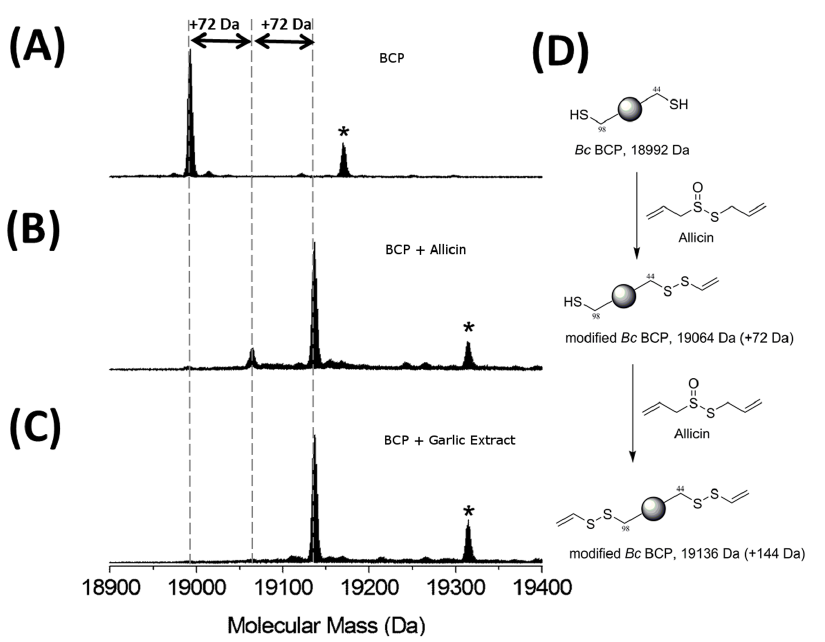
Figure 4. MS analysis of recombinantly produced Burkholderia cepacia BCP Prx incubated with AAS and AGE. (A) Purified Bc BCP Prx has a mass of 18992 Da, consistent with its predicted mass based on the amino acid sequence (B) Bc BCP after incubation with 1 mM AAS for 1 h results in the formation of two covalently modified species of mass increases + 72 Da and + 144 Da. (C) Bc BCP Prx after incubation with AGE for 1 h results in the formation of a covalently modified species of mass increase + 144 Da corresponding to the addition of two allicin adducts. * denotes enzyme species that undergo a -N-gluconoylation during protein expression. (D) Proposed mechanism of reaction of allicin with Bc BCP